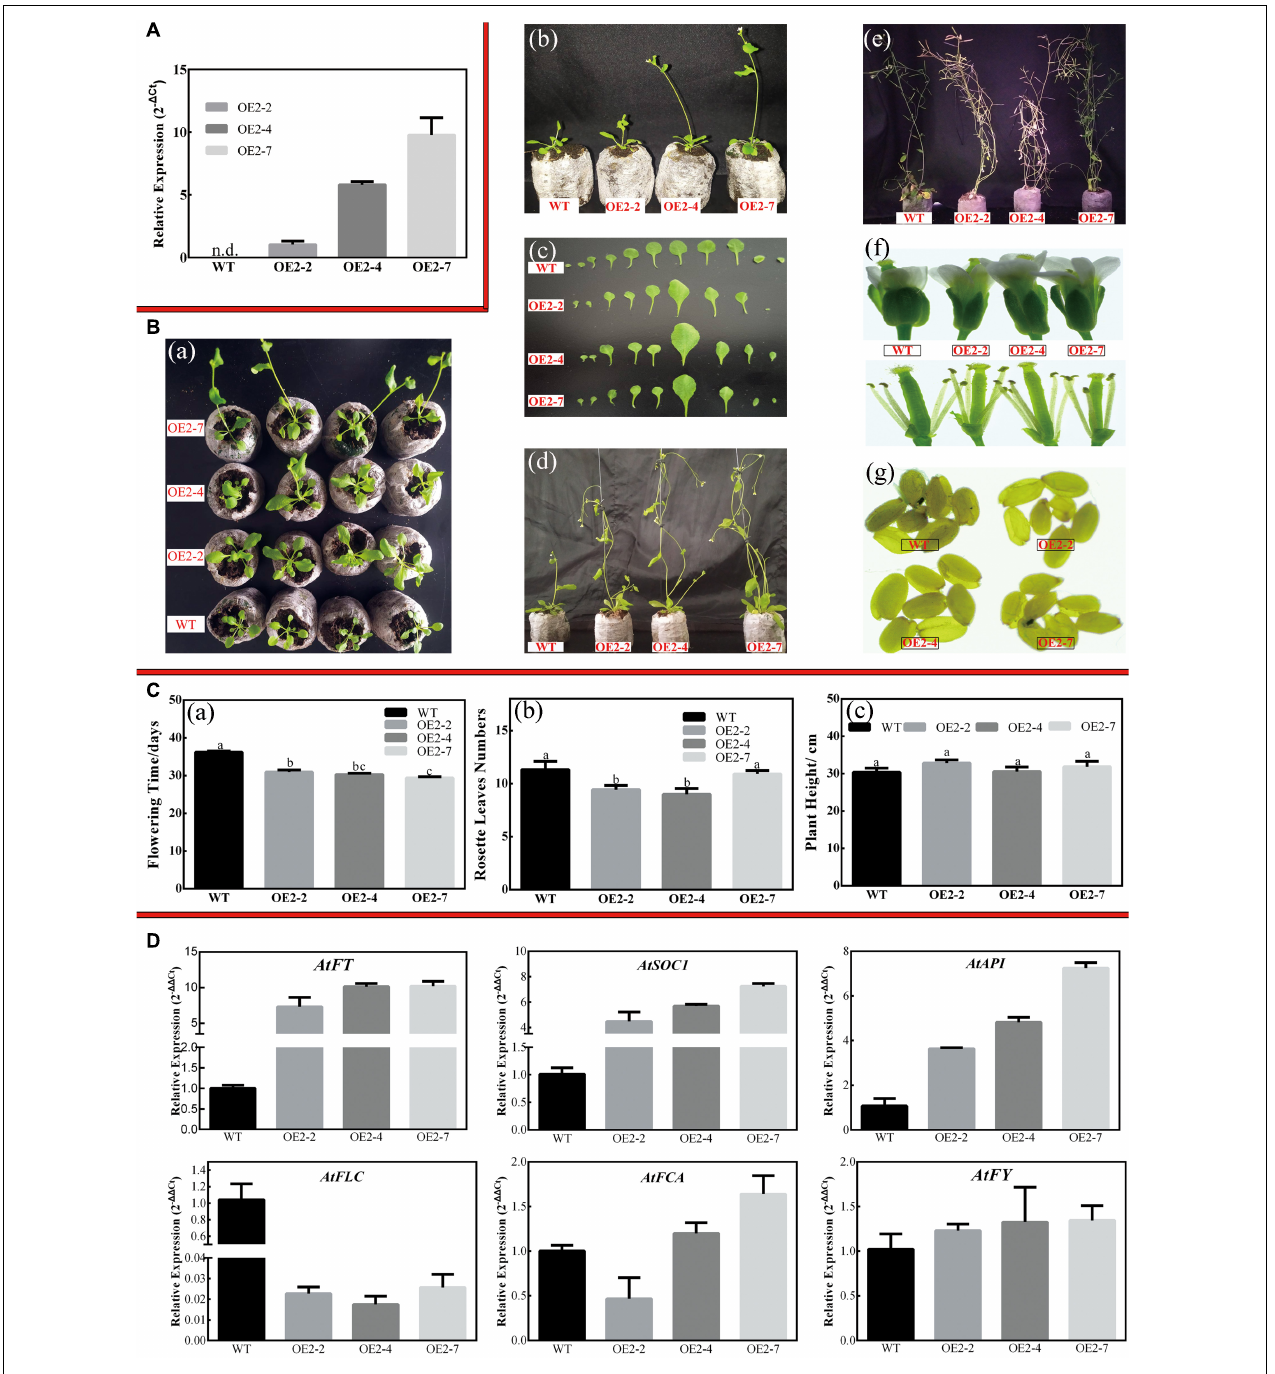
FIGURE 7 | Overexpression of CsPMEI2 promotes early flowering in transgenic Arabidopsis under LD condition. (A) The expression of CsPMEI2 in three CsPMEI2 -OE lines and WT plants. The relative expression levels were calculated by using 2 - (cid:49) Ct method. Data are shown as the means ± SE ( n = 3). (B) Early flowering phenotypes of CsPMEI2 -OE lines grown under LD condition. (a) Early-flowering phenotype; (b) phenotypes of CsPMEI2 -OE lines and WT plants after 29 days of growth under LD condition; (c) leaf size; (d) phenotypes of CsPMEI2 -OE lines and WT plants after 38 days of growth under LD condition; (e) phenotypes of CsPMEI2 -OE lines and WT plants at senescence stage; (f) flowers of WT and CsPMEI2 -OE lines; (g) seed size of WT and CsPMEI2 -OE lines. (C) Flowering time, rosette leaves, and plant height of WT and CsPMEI2 -OE lines at the just bolting stage. (a) Flowering time; (b) rosette leaves numbers; (c) plant height. (D) Expression analysis of flowering-related genes. The final results were calculated with 2 - (cid:49) (cid:49) Ct method. Data are shown as the means ± SE ( n = 3).